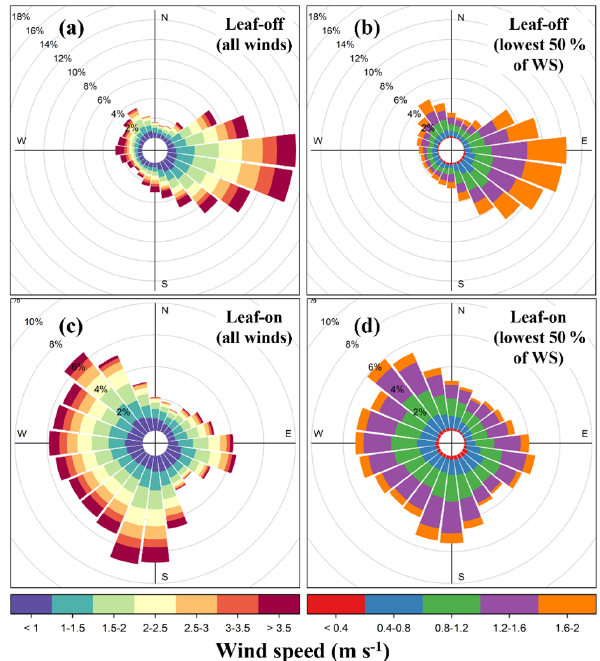
Figure 4. Wind roses for BIFoR FACE during the 2019–2021 (a, b) leaf-off and (c, d) leaf-on periods (see Sect. 2.1 for site de- scription and Sect. 2.2 for observation details). The wind roses are calculated on 5min averages of sonic measurements in array 1. Pan- els (a) and (c) show wind roses across all wind conditions; pan- els (b) and (d) show wind roses for the lowest 50% of wind speeds, used in the residence-time calculations (Sect. 2.3). The wind roses for the other fumigation arrays are very similar and are omitted to avoid repetition. Note the change of scale between panels (a) and (c) on the one hand and panels (b) and (d) on the